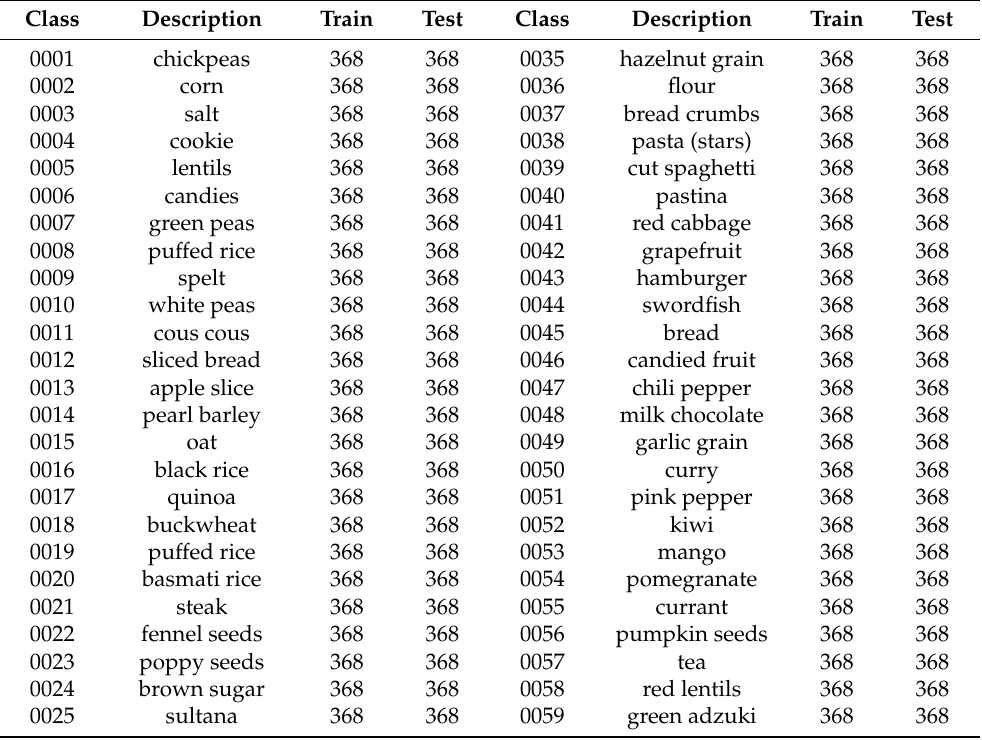
Table 3. The RawFooT dataset